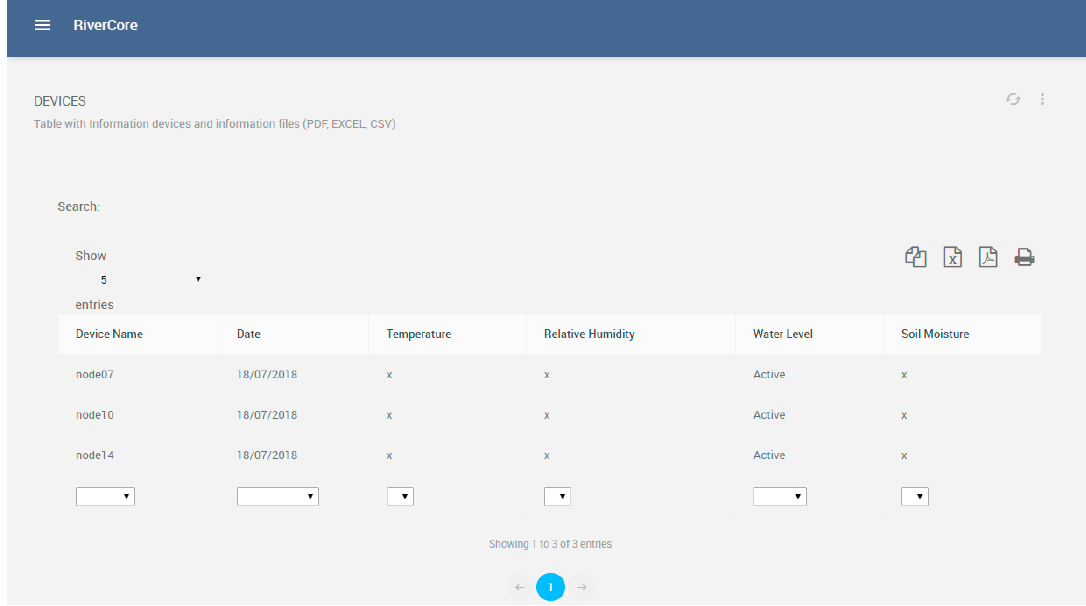
Figure 11. Device management view.